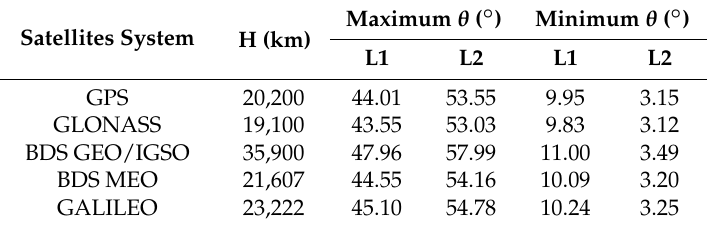
Table 3. Altitudes and geocentric angles between the LEO and the different GNSS satellites.